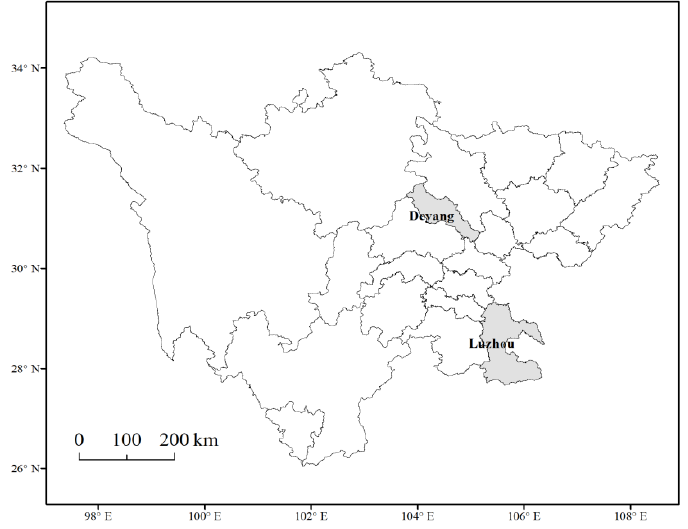
Table 1. Soil properties of the experimental fields .